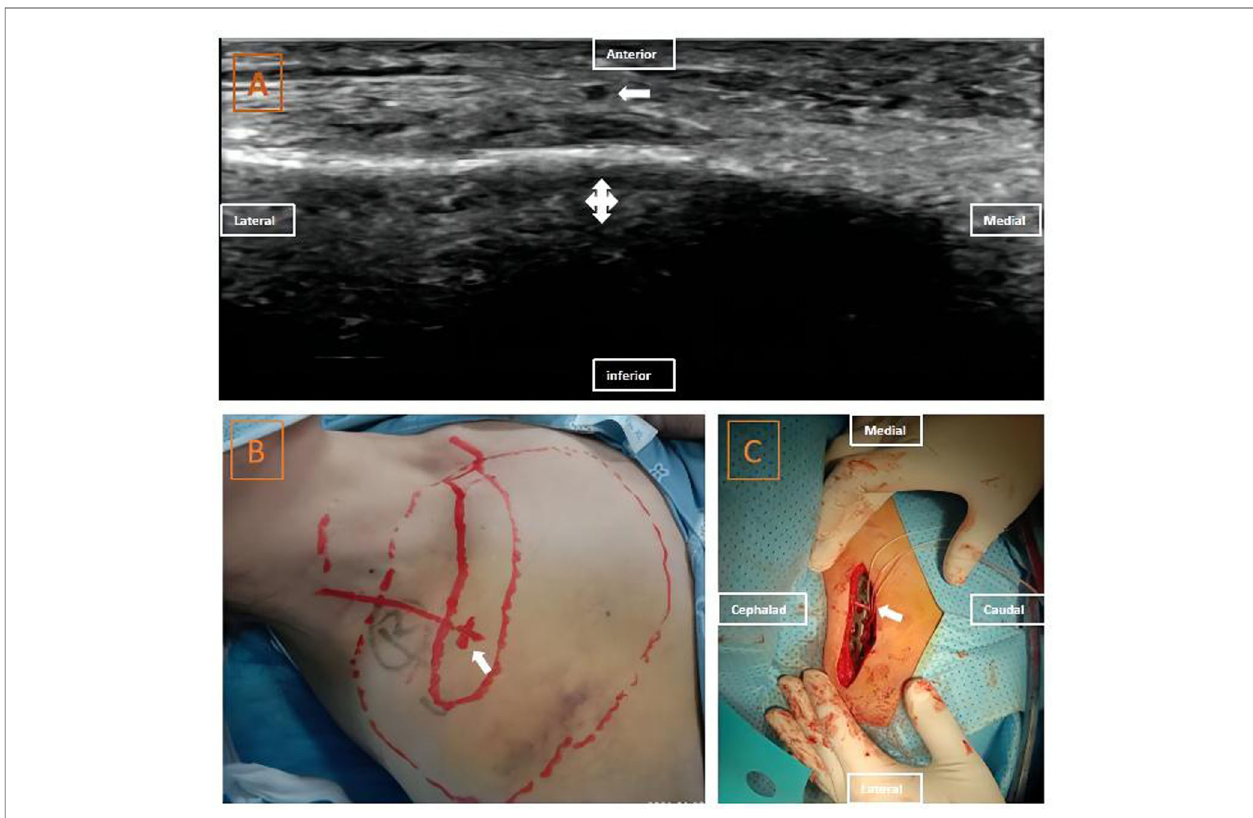
FIGURE 2 | Ultrasound images, projection on the body surface, sensory block area and intraoperative view of supraclavicular nerve in case 2: ( A ) ultrasound images of the supraclavicular nerve anterior to the clavicle; ( B ) projection of the supraclavicular nerve on the body surface and the sensory block area. ( C ) intraoperative view of the supraclavicular nerve. The thick white arrow indicates the supraclavicular nerve; the cross arrow indicates the